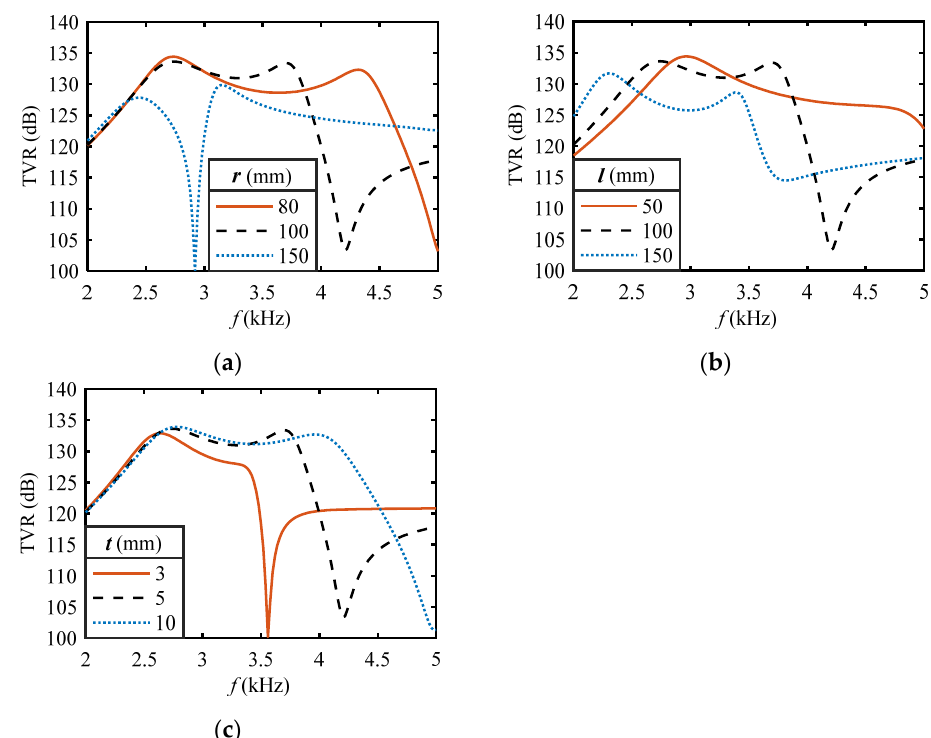
Figure 8. The variation curve of TVR with baffle size (( a ) radius, ( b ) length, ( c ) thickness).